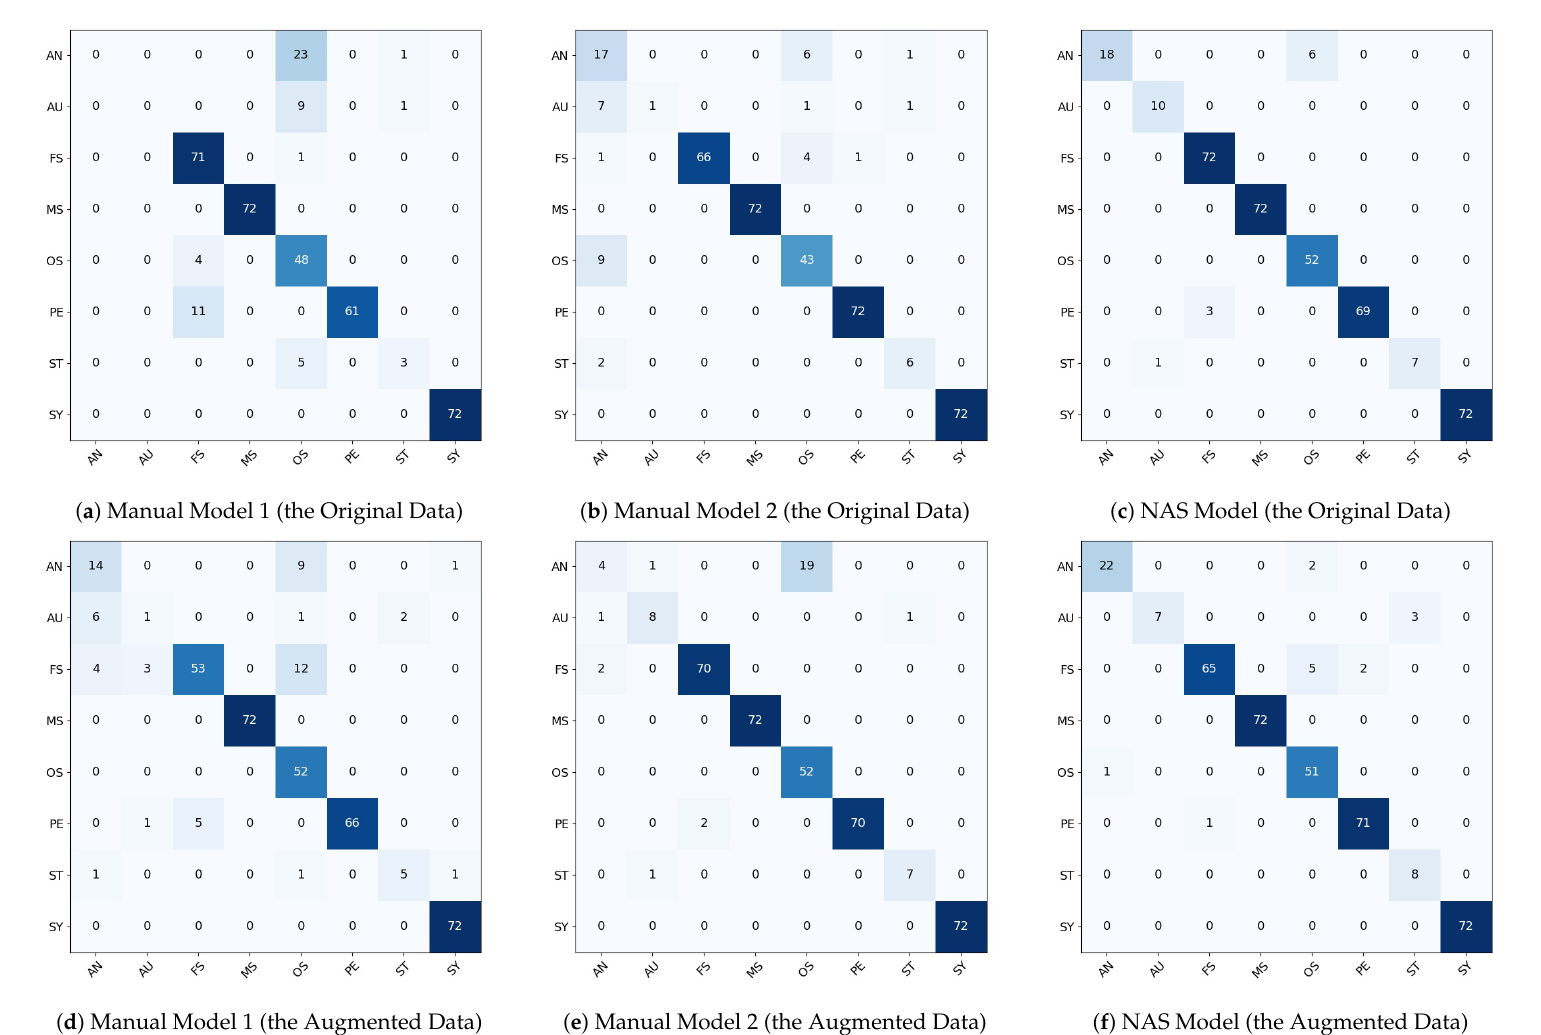
Figure 9. Confusion matrices for each CNN model